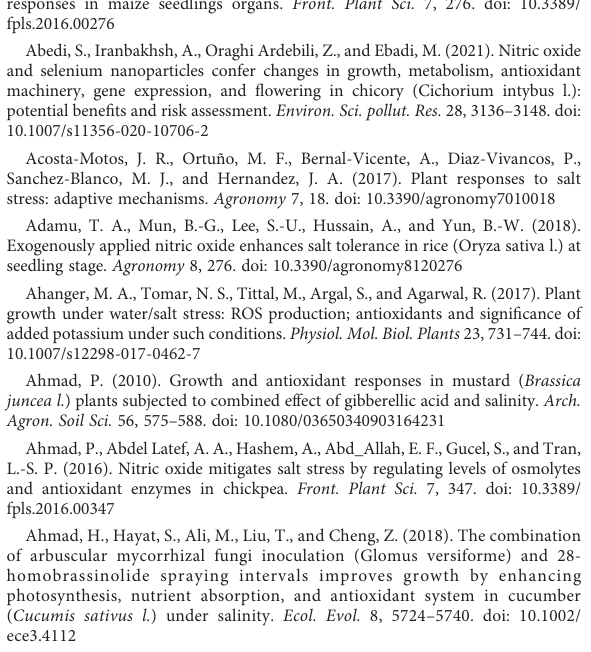
SUPPLEMENTARY FIGURE 1 Effects of different concentrations of NO and salinity on SDW (A, B) and RDW (C, D) of different plant species. SUPPLEMENTARY TABLE 1 List of published research articles used for data extraction in this meta-analysis. SUPPLEMENTARY TABLE 2 Comparative effects of different salinity levels on shoot and root biomass production in NO-treated plants. SUPPLEMENTARY TABLE 3 Heterogeneity statistics for the growth-related traits summary effect sizes under non-saline and saline stress